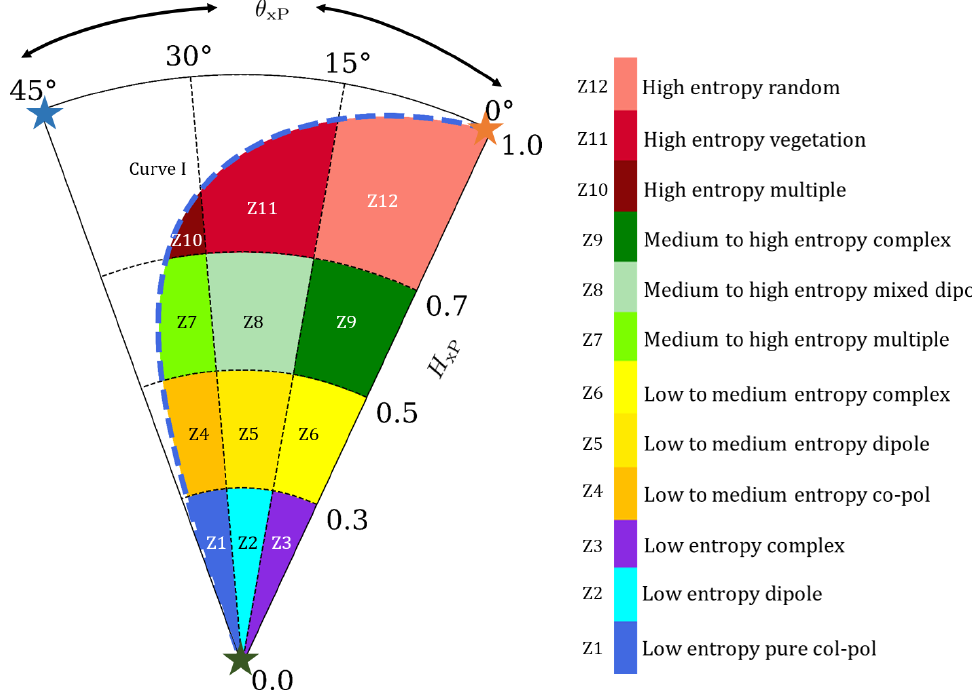
Figure 4. Variations of θ xP and H xP for bare field conditions and fully developed crops. These measurements are derived over in-situ fields.